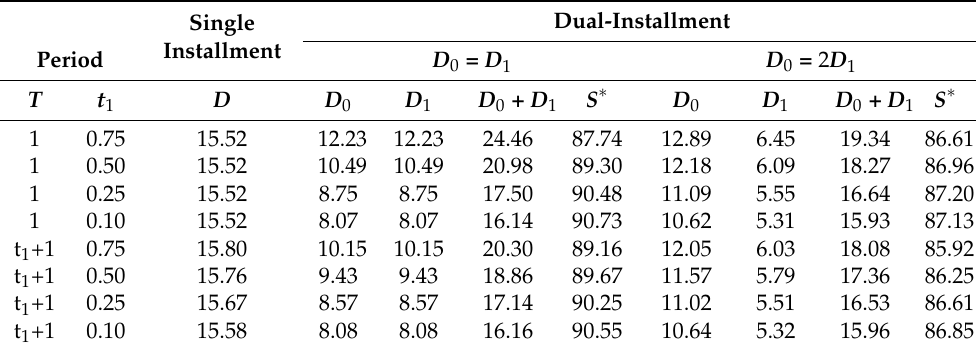
Table 1. Fair Deposits for Single-Installment and Dual-Installment Models. Single Installment